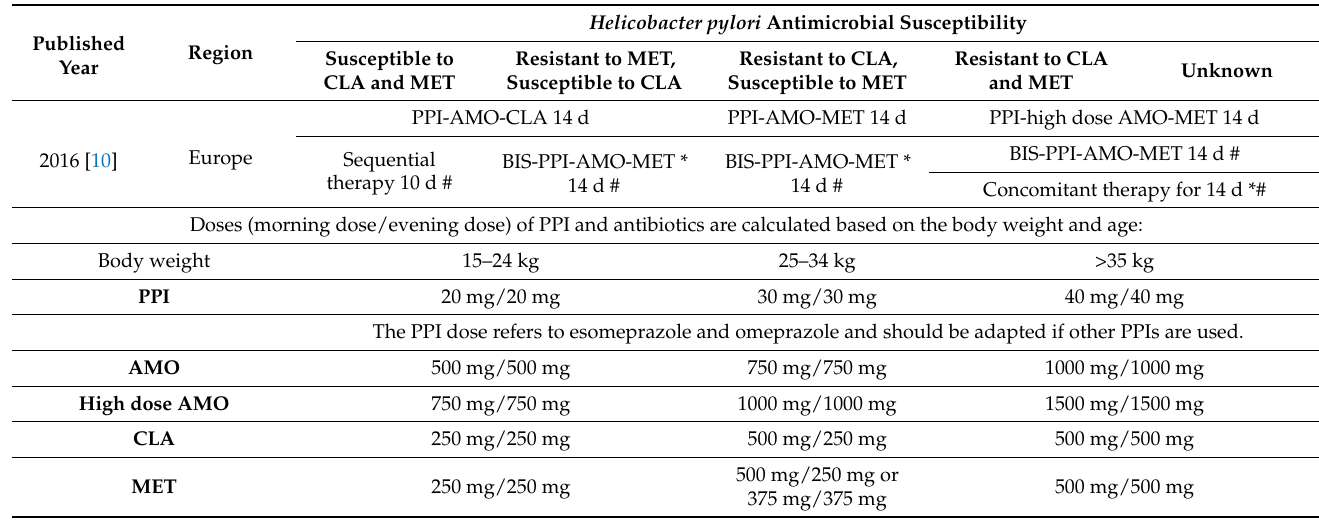
Table 1. Recommended options for first-line therapy of Helicobacter pylori